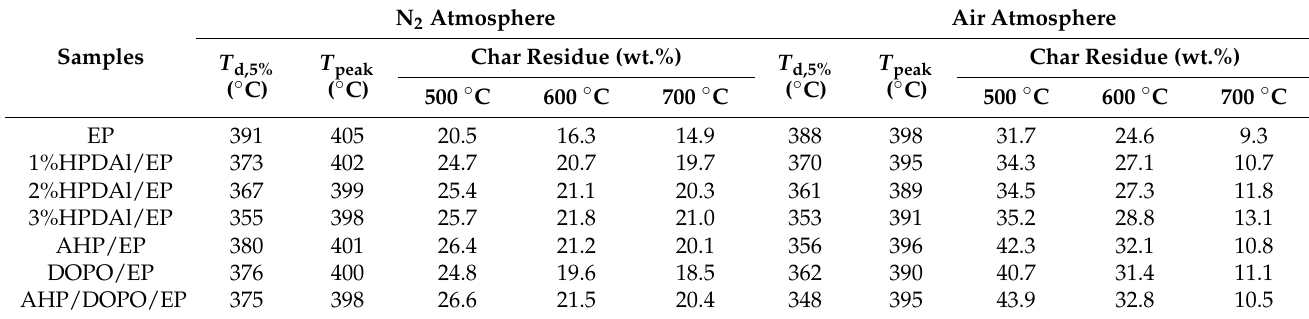
Table 2. Thermal behavior and charring parameters of EP composites.